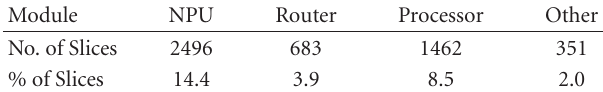
Table 3: FPGA synthesis results.